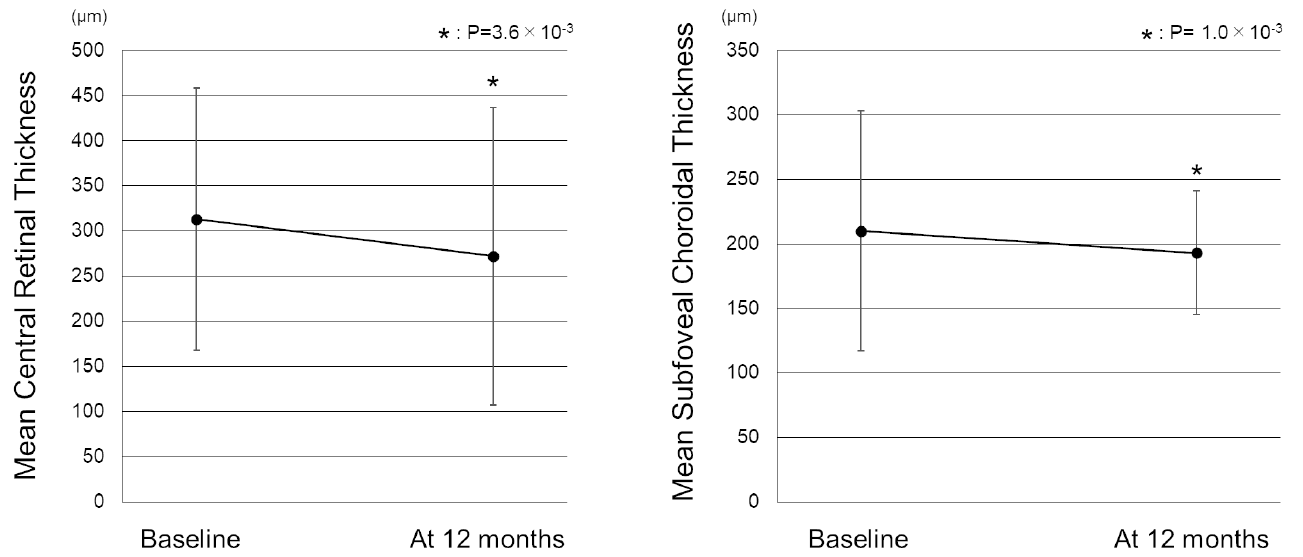
Figure 3. Change in the mean central retinal thickness and subfoveal choroidal thickness before and after switching to brolucizumab. ( Left ) The mean CRT significantly decreased from 313 ± 145 µm at baseline to 272 ± 165 µm 1 month after switching ( p = 3.6 × 10 −3 ). ( Right ) The mean SCT also signifi- cantly decreased from 210 ± 93 µm at baseline to 193 ± 48 µm at 12 months after switching ( p = 1.0 × 10 −3 ) CRT: central retinal thickness, SCT: subfoveal choroidal thickness.